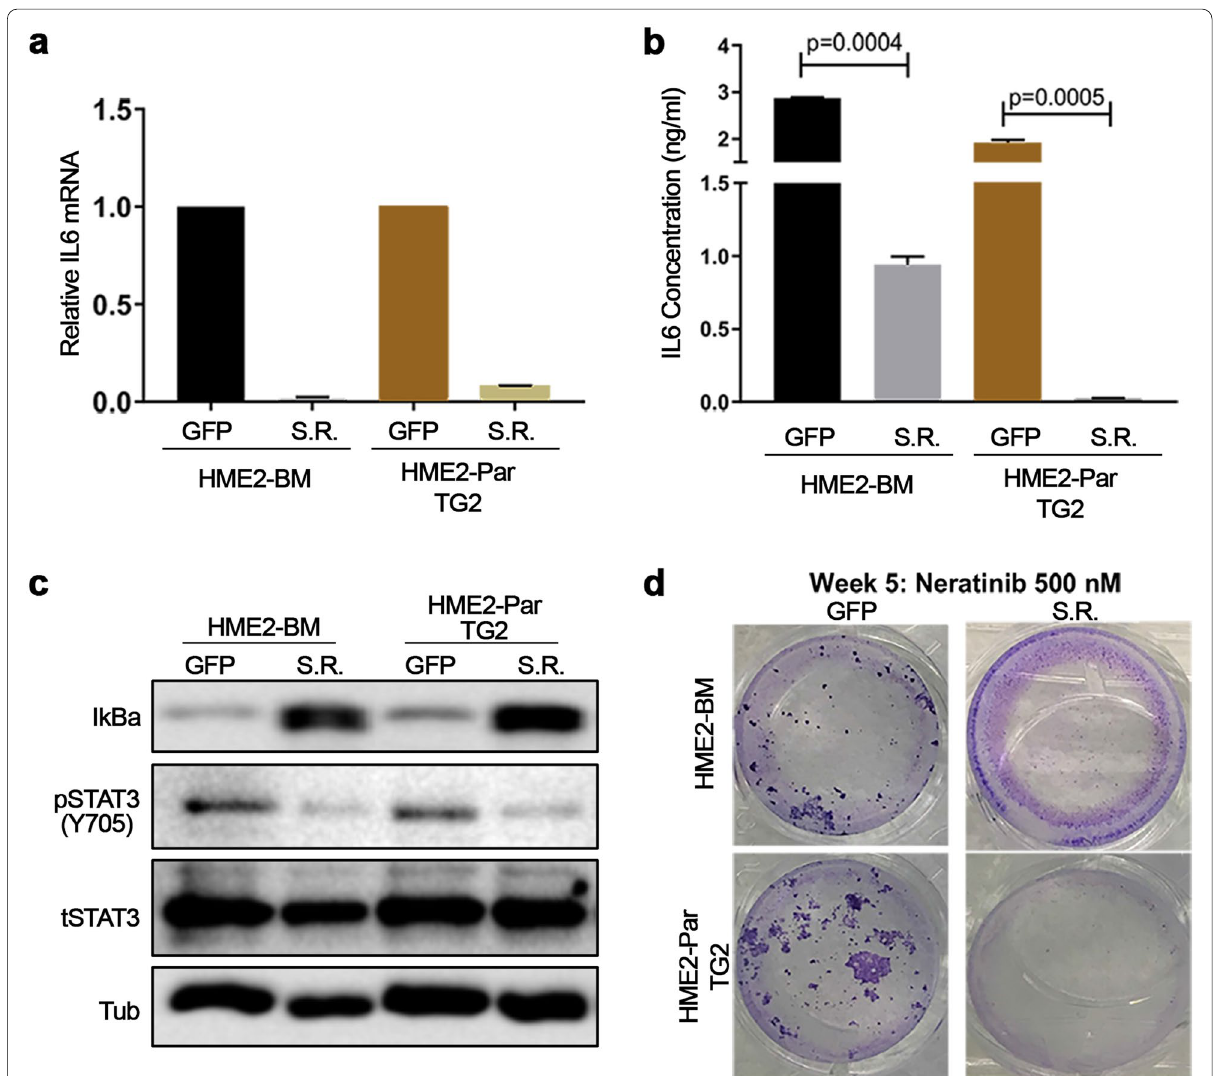
Fig. 4 Transglutaminase 2-mediated activation of NF-κB is required for acquisition of neratinib resistance. a,b HME2-BM cells and TG2 overexpressing HME2-Parental (Par) cells were further constructed to express the NF-κB super repressor (S.R.) or GFP as a control and IL-6 was quantified using qRT-PCR ( a ) and AlphaLISA ( b ). c The constructed cell lines described in panel a in were serum starved overnight and analyzed for Iκbα (IkBa) expression and phosphorylation of STAT3. Analysis of total levels of STAT3 and β-tubulin served as loading controls. Immunoblots are representative of at least three independent experiments. d The constructed cell lines described in panel a were treated with neratinib every three days. Crystal violet was used to visualize viable cells in representative